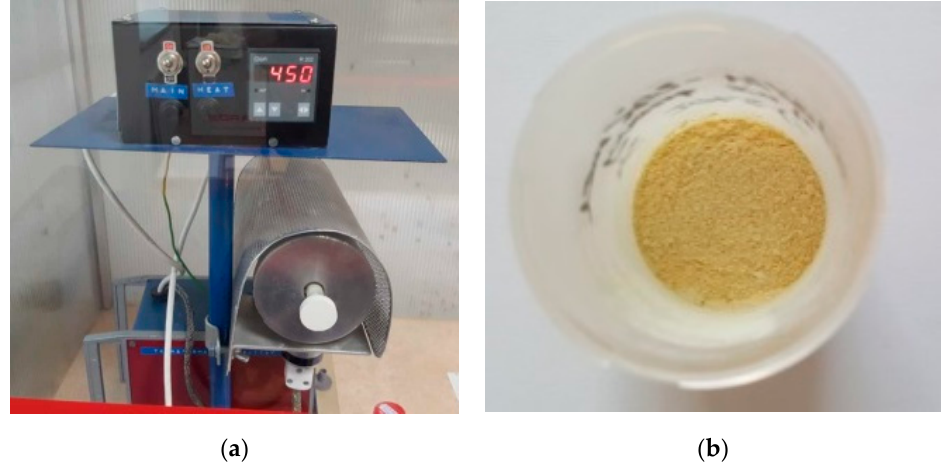
Figure 7. ( a ) Homemade tube furnace used for nanocomposites synthesis; ( b ) PCN nanocomposite obtained at 400 °C.